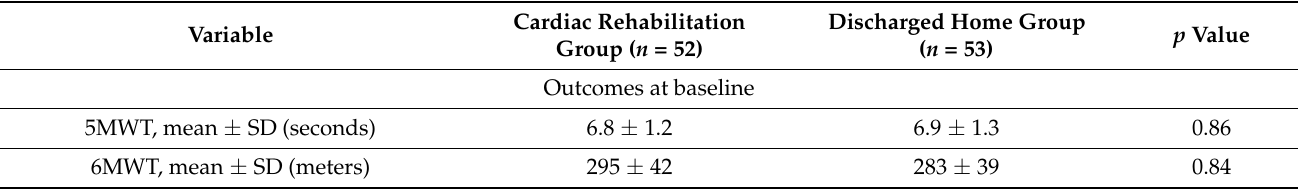
Table 2. Study outcomes at baseline, 30 days, 6 months, and 12